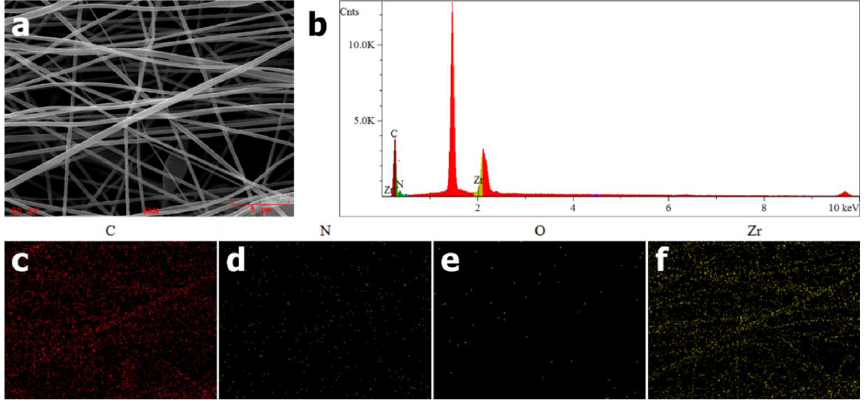
Figure 2. ( a ) SEM image and ( b ) energy-dispersive spectroscopy (EDS) results of PAN-PCN 0.6% nanofibers. ( c–f ) EDS mappings identifying the elemental distributions of C, N, O and Zr.